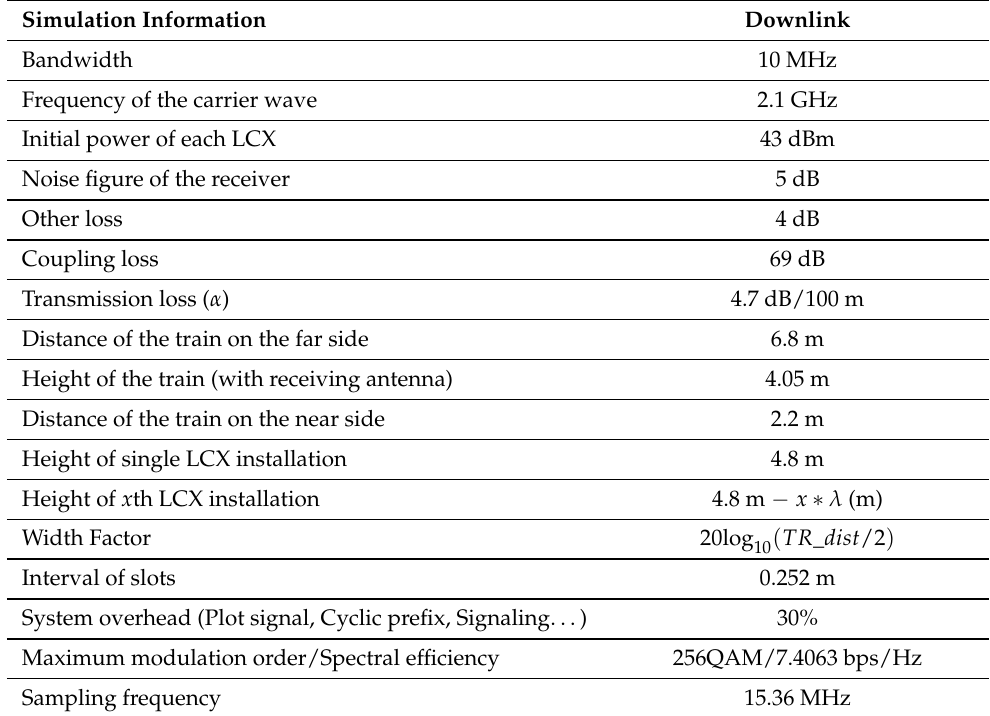
Table 1. Parameters in the